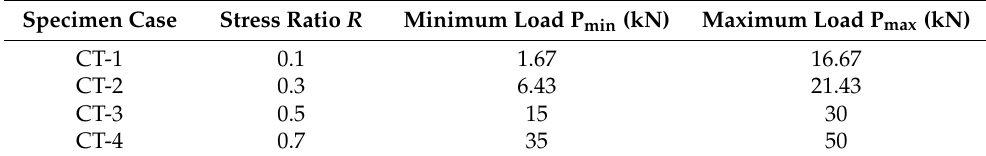
Figure 2. Size of CT specimen (unit: mm). Table 2. Test loading scheme.